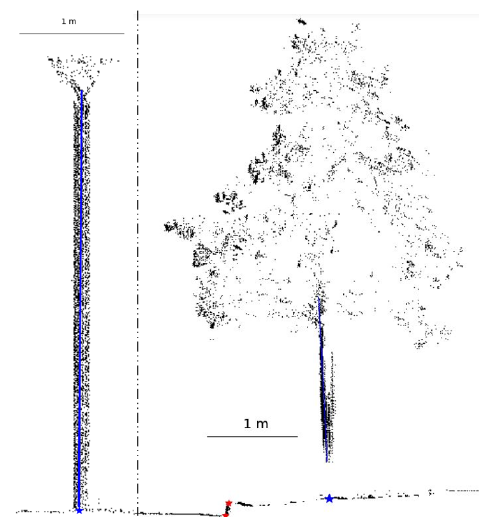
Figure 7 : Some vectorization results, a streetlamp (right) and a tree (left).